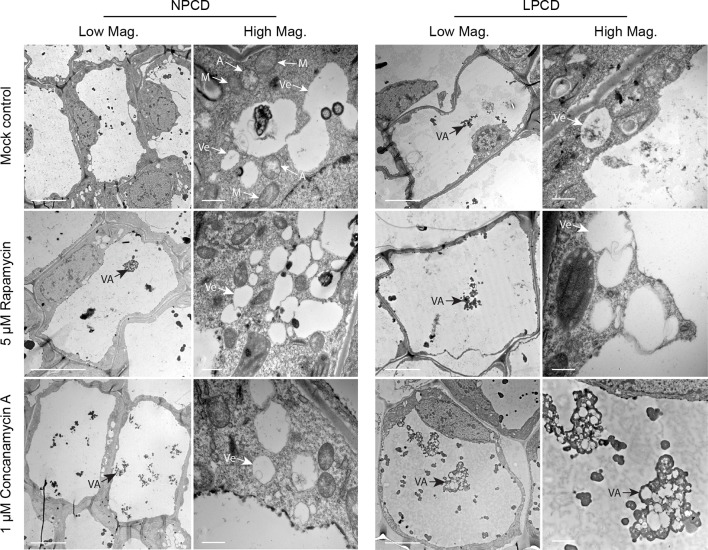
Non-programmed cell death (NPCD) and late-PCD (PCD) cells treated with 0.05% DMSO (mock control), 5 µM rapamycin, or 1 µM concanamycin A. Note that concanamycin A–treated cells contained large vacuolar aggregates. A = autophagosome-like vesicle; M = mitochondria VA = vacuolar aggregate; Ve = single membrane vesicle. Scale bars: (Low Mag.) = 20 µm; (High Mag.) = 1 µm.